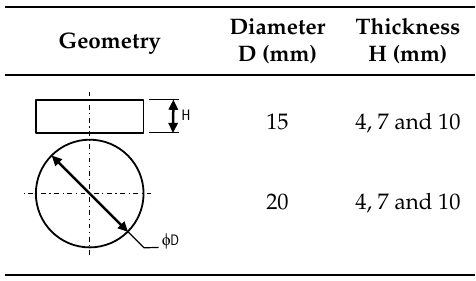
Table 1. Different sensing element